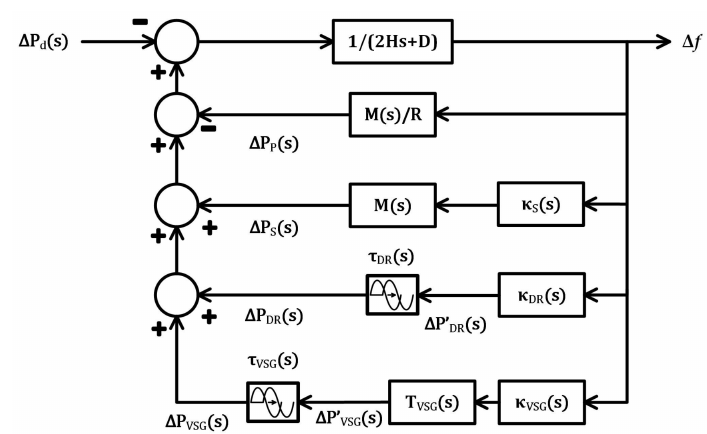
Figure 2. The modified representation of power system model relating frequency deviation to a power disturbance.